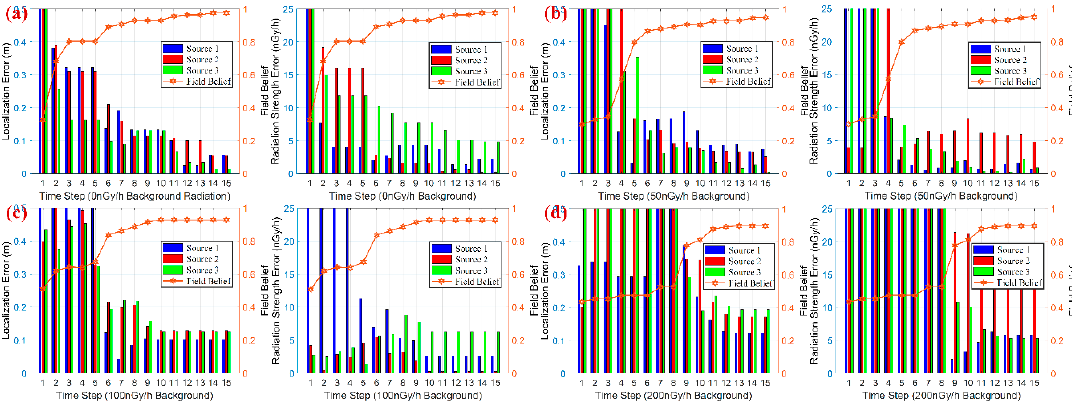
Figure 7. Localization and strength error with different background radiation. ( a – d ) respectively illustrates the estimation results with background radiation level of 0, 50, 100 and 200